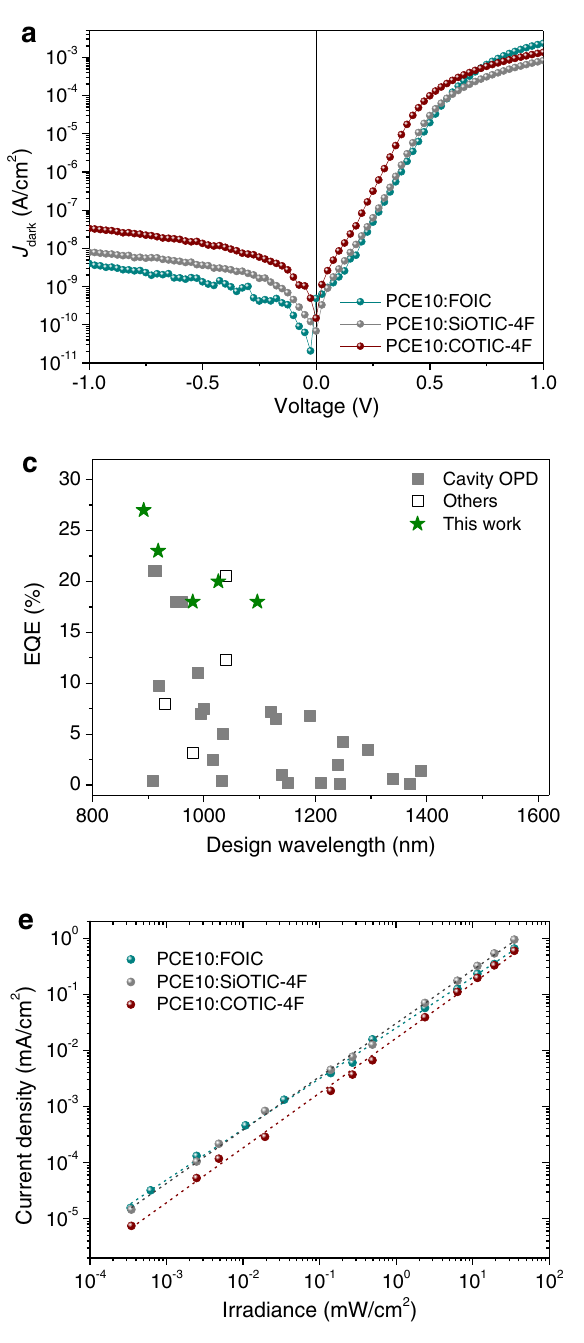
Fig. 5 | Performance of narrowband near-infrared OPDs. a Dark current density – voltage ( J – V ) characteristics of PCE10: FOIC (600nm), PCE10: SiTOC-4F (600nm)andPCE10:COTIC-4F(500nm)narrowbandNIR-OPDs. b Corresponding speci fi cdetectivity(D*)spectra.DashlinespresentthecalculatedD*atshort-circuit condition. ( c ) and ( d ) are the comparison of the achieved performance for the PCE10:NFAnarrowbandOPDstootherrecentreportednarrowbandNIR-OPDswith the designed λ det in the range of 890 – 1400nm. The solid lines represent the